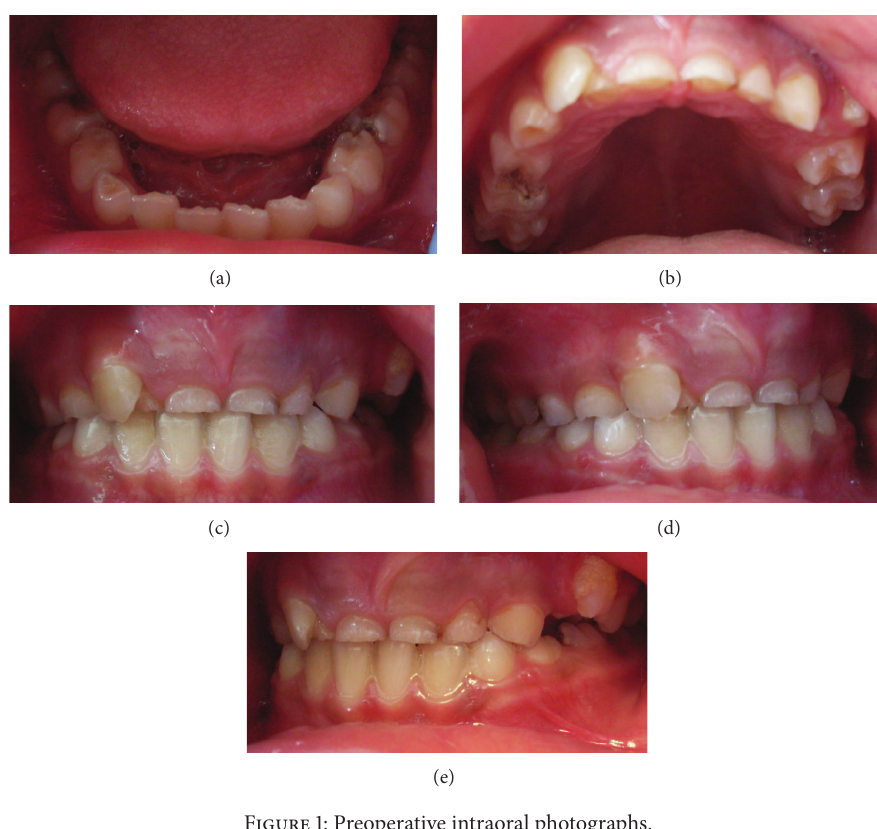
Figure 1: Preoperative intraoral photographs.